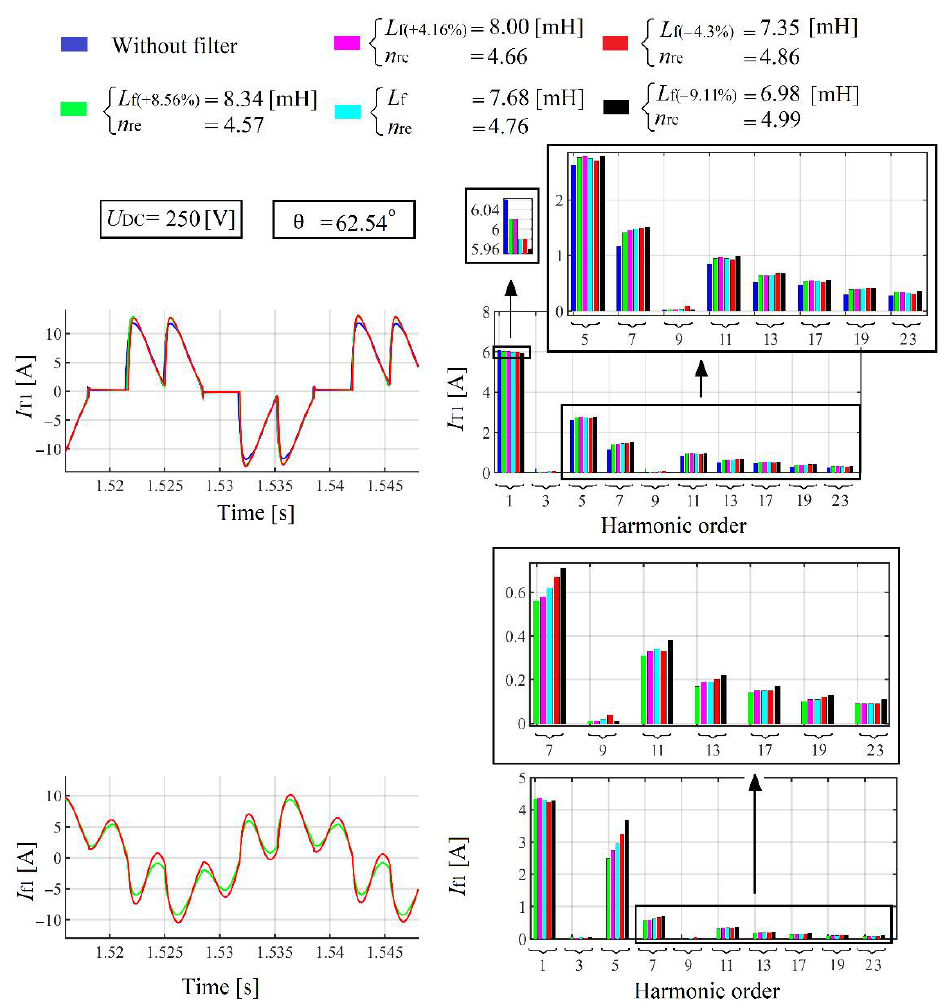
Figure 55. Input rectifier and filter current waveforms and spectrums.